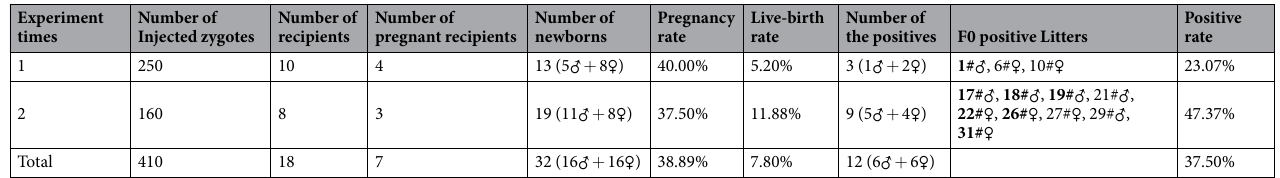
Table 1. Generation of a genetically modified mouse model. 5 ng/ µ l Cas9 mRNA, 2.5 ng/ µ l sgRNAs and 5 ng/ µ l donor vector targeting the site 2 locus were co-injected into zygotes of the C57BL/6 mouse. To circumvent random integrations, a circular donor vector was used instead of a linear one. The sex distributions of the total number of newborns and positive newborns are shown in parentheses respectively. The F0 positive mice used to produce offspring are labelled in